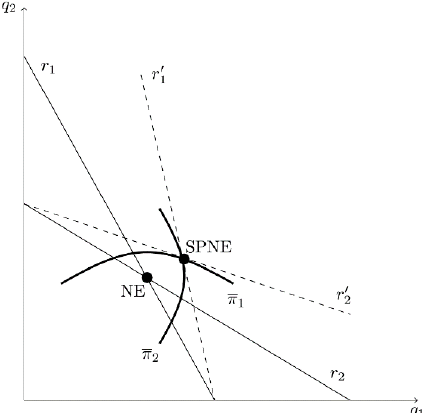
Figure 4. The Subgame ‐ Perfect Nash Equilibrium ( SPNE ) When Owners Hire CEOs Who Underes ‐ timate Product Substitutability.